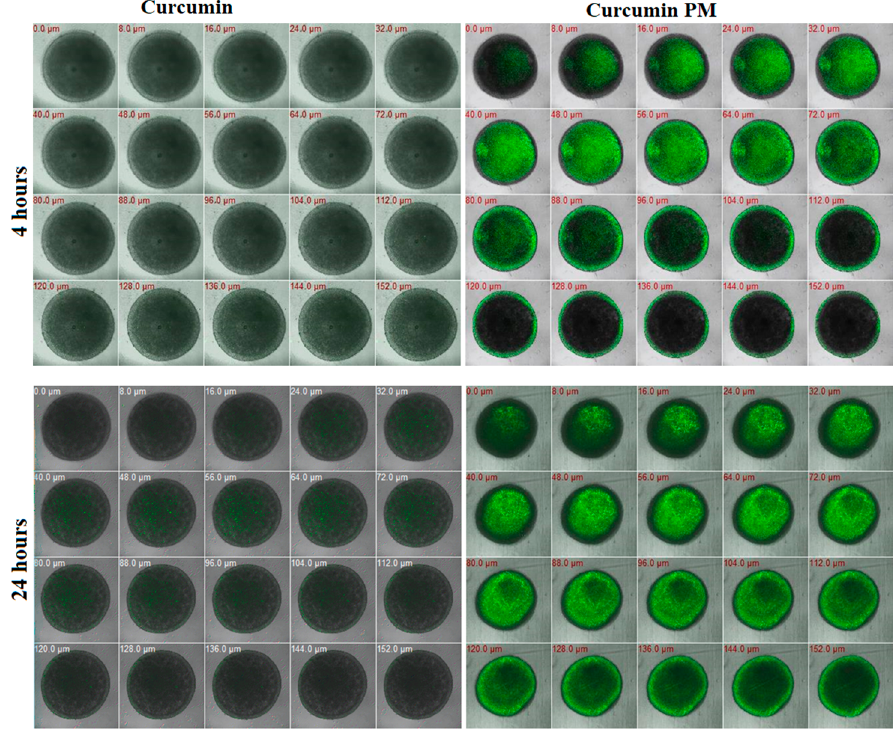
Figure 2. The absorption of curcumin PM into MCF7 spheroids was visualized by the autofluorescence of curcumin in the nanoparticle complex. Spheroids were incubated with nanocurcumin at a concentration of 30 µg/mL. The images were taken after 4 h and 24 h of incubation on LSM 510. The upper-left value in each image represents the depth from the spheroid’s top (i.e., 0.0 µm means that this is the spheroid’s top surface). The fluorescence level reached a maximum after 24 h of incubation. It can be seen that curcumin PM is present not only on the outside but also on the inside, near the necrotic core of spheroids; meanwhile, a very weak fluorescence signal was observed in the free curcumin.